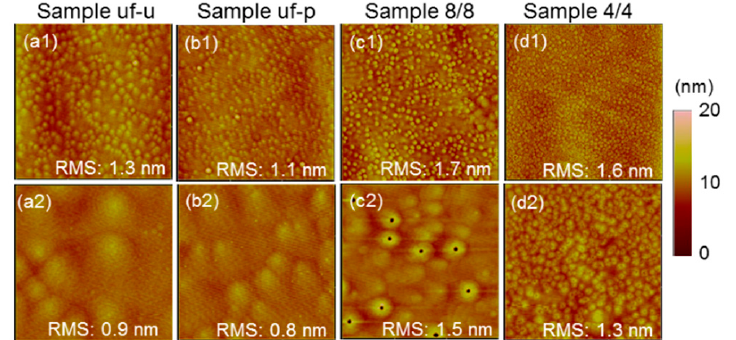
Figure 4. ( a1 – d1 ) ( a2 – d2 ) atomic force microscopy (AFM) images of samples uf-u, uf-p, 8/8, and 4/4, respectively, with (15 μ m × 15 μ m) (3 μ m × 3 μ m) in image dimension.